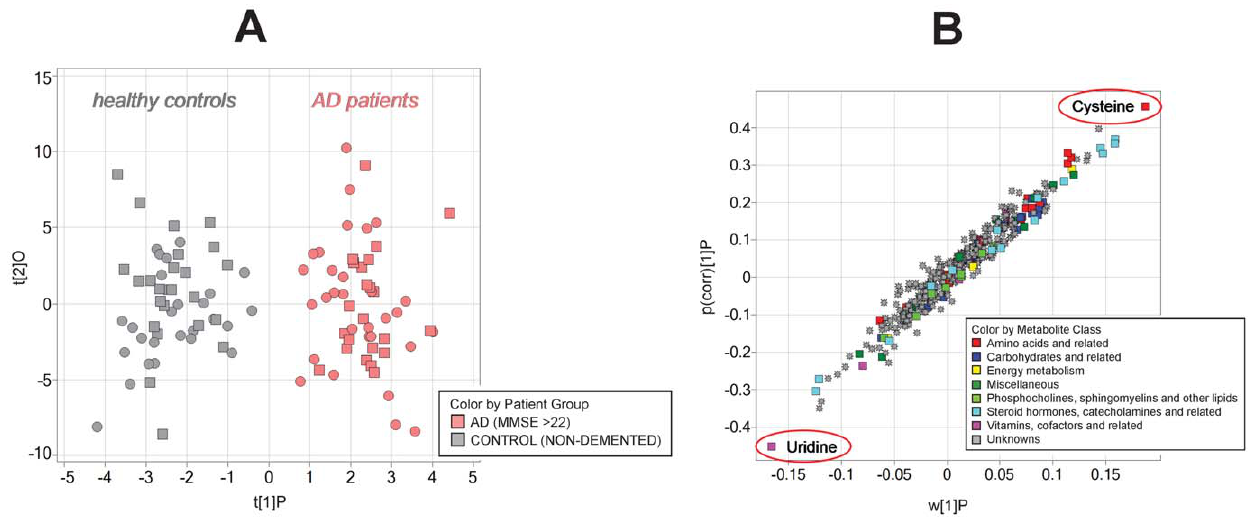
Figure 5. Determination of analytes contributing significantly to separation between AD patients and healthy controls by O-PLS- DA of the CSF data set. (A) OPLS-DA score plot for light AD patients (MMSE . 22) vs. controls. (B) OPLS-DA coefficient plot for light AD patients (MMSE . 22) vs. controls. Cysteine and uridine are the most relevant analytes for separating light AD patients (MMSE . 22) from healthy subjects.